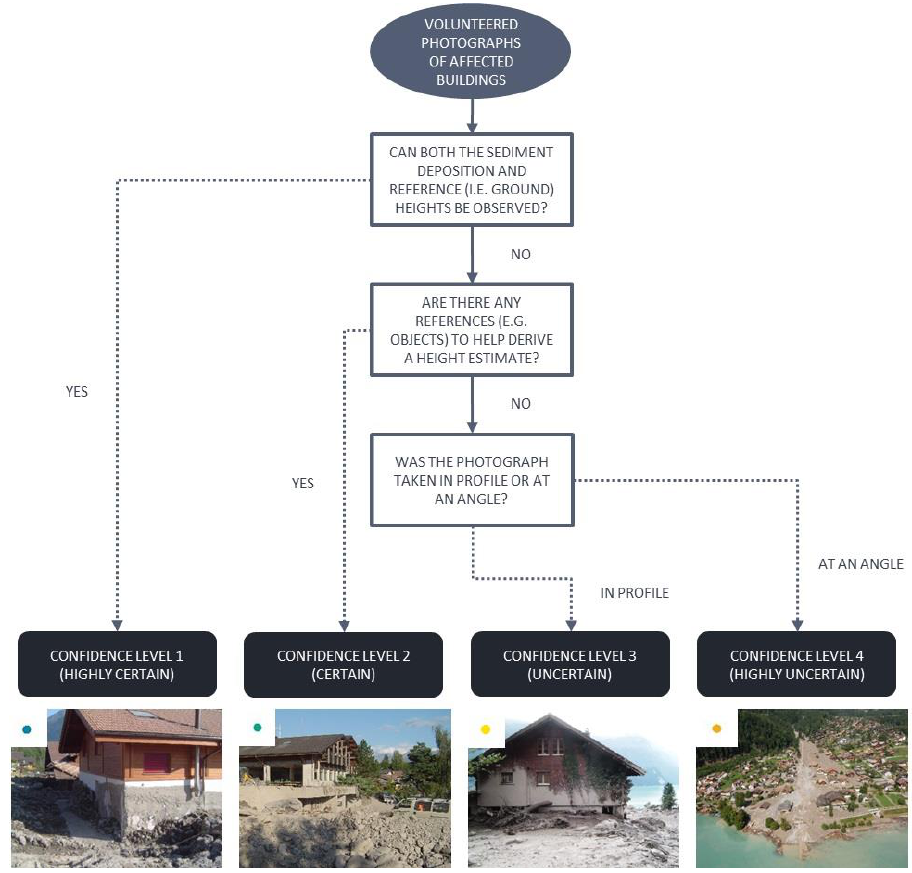
Figure 4. Selected examples of post-event photographs of affected buildings in Brienz; sediment deposition heights estimated from the photographs are associated with variable levels of confidence. Table 3. Summary of selected rheological values from the literature to evaluate with the FLO-2D model with respect to the 2005 debris flow event, in lieu of location-specific post-event field samples; a unique ID is assigned to each group of values. Yield Stress (T y ) Viscosity ( n )